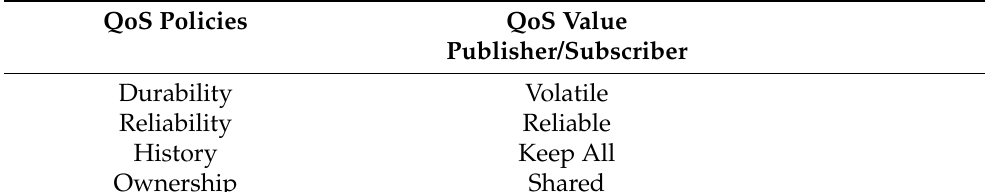
Table 6. Quality of services (QoS) policies.